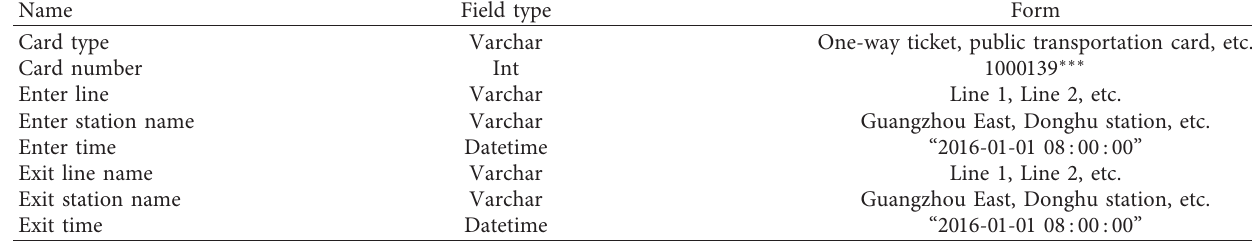
Table 1: The Automatic Fare Collection data types.